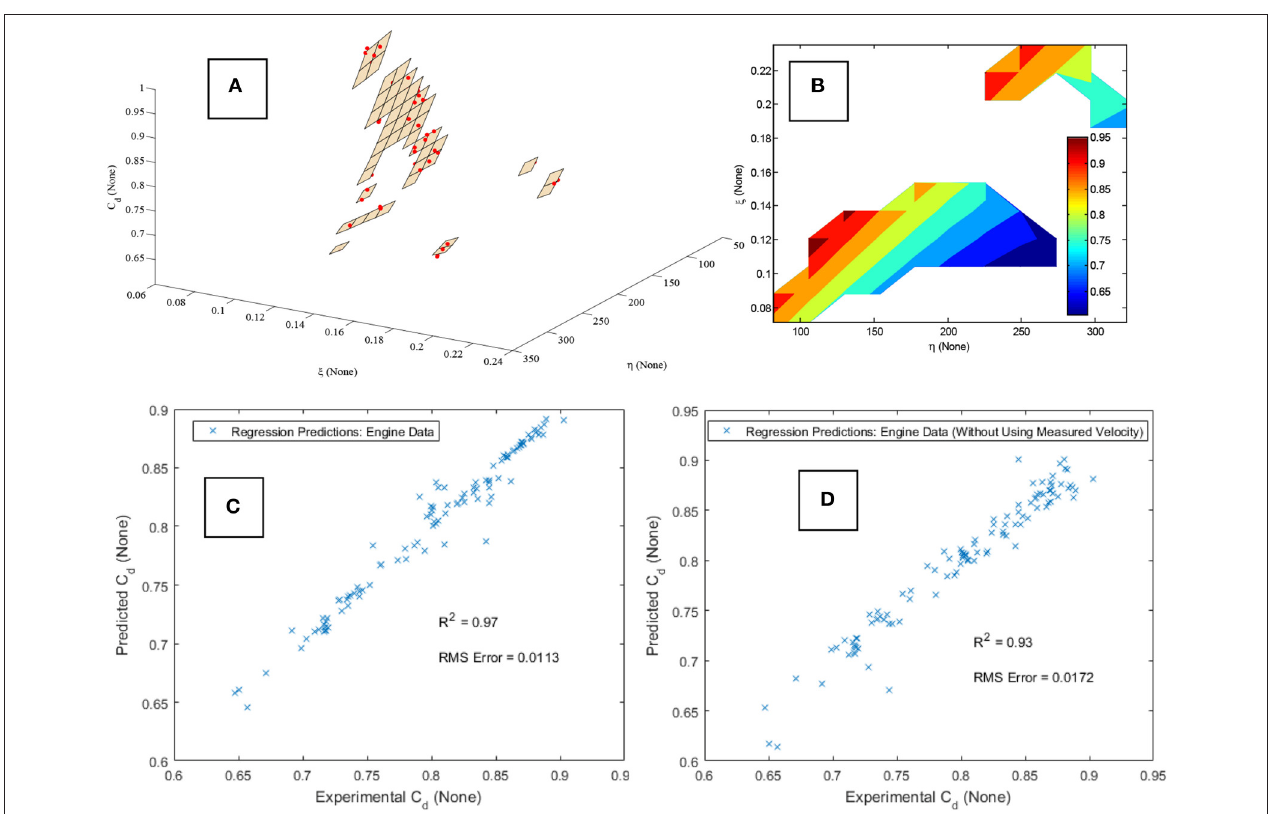
FIGURE 8 | (A,B) The surface and contour plots for the engine data show a similar but less non-linear η - ξ surface than Figures 5C,D . (C,D) Engine data regression predictions using average velocity (C) and without using measured velocity (D) , corresponding to the apparatus data regression predictions of Figures 6A and C respectively. Results for both the choked ( N 62) and non-choked ( N 43) data points have been = =